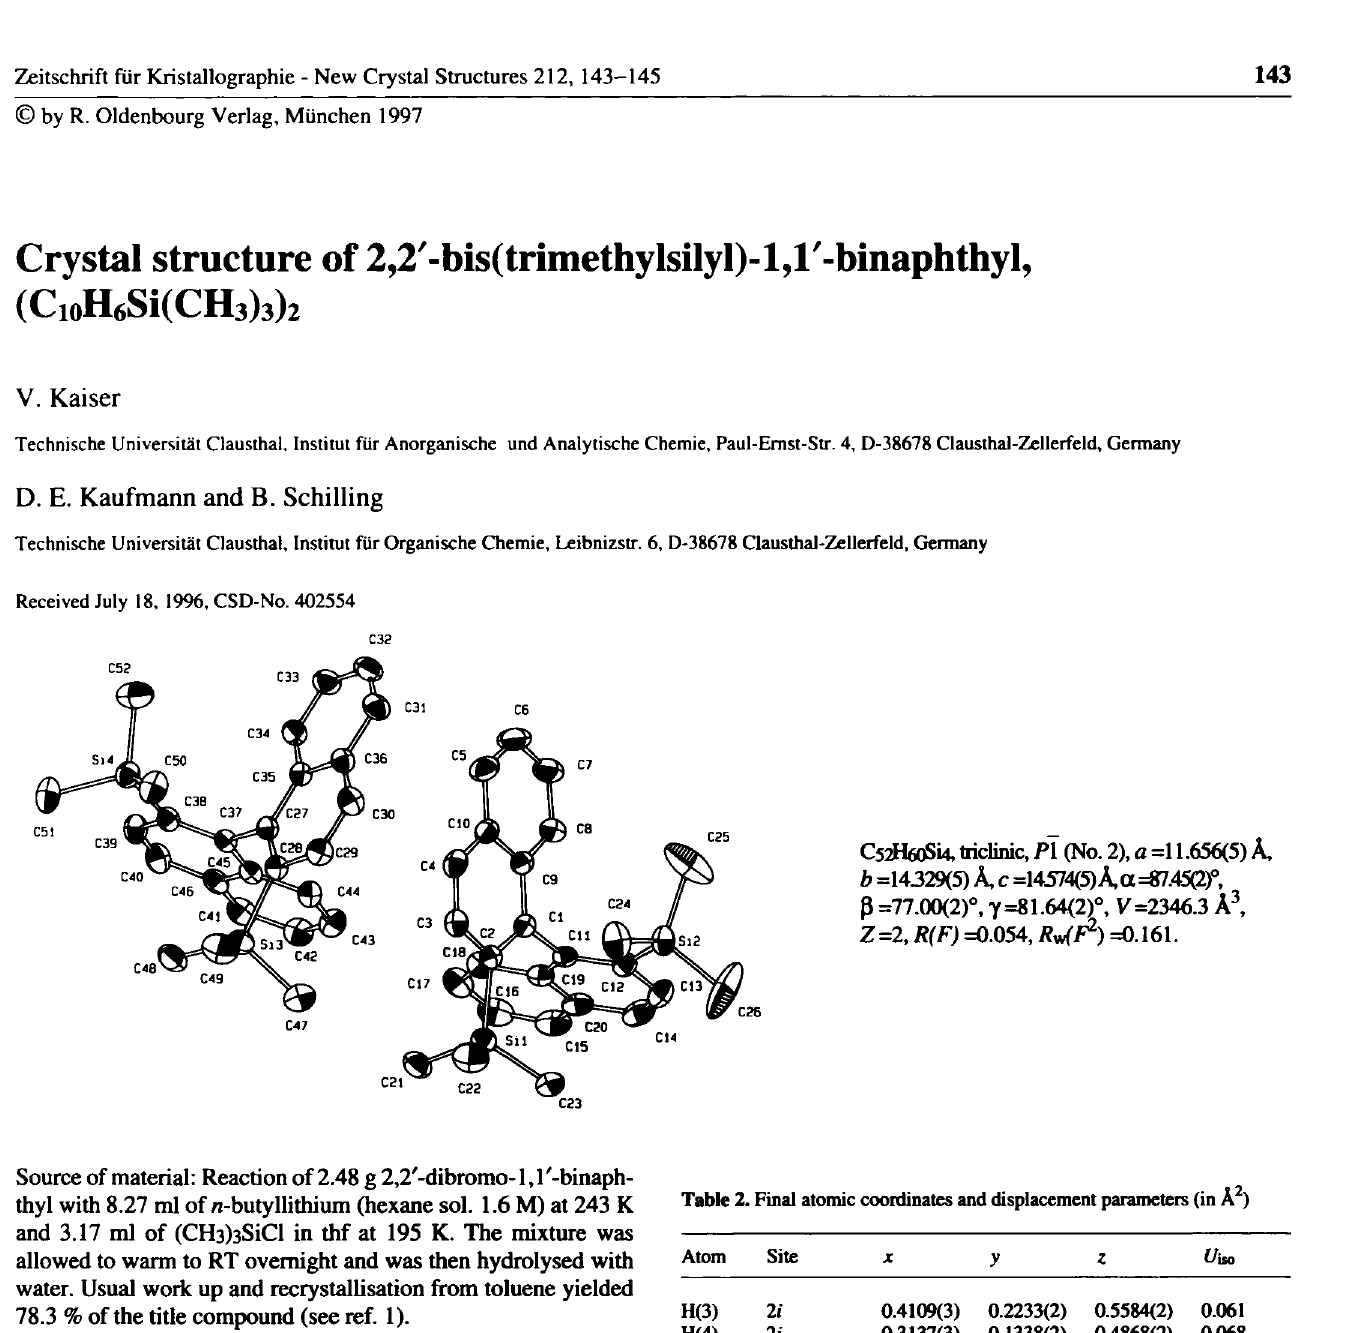
Table 1. Parameters used for the X-ray data collection